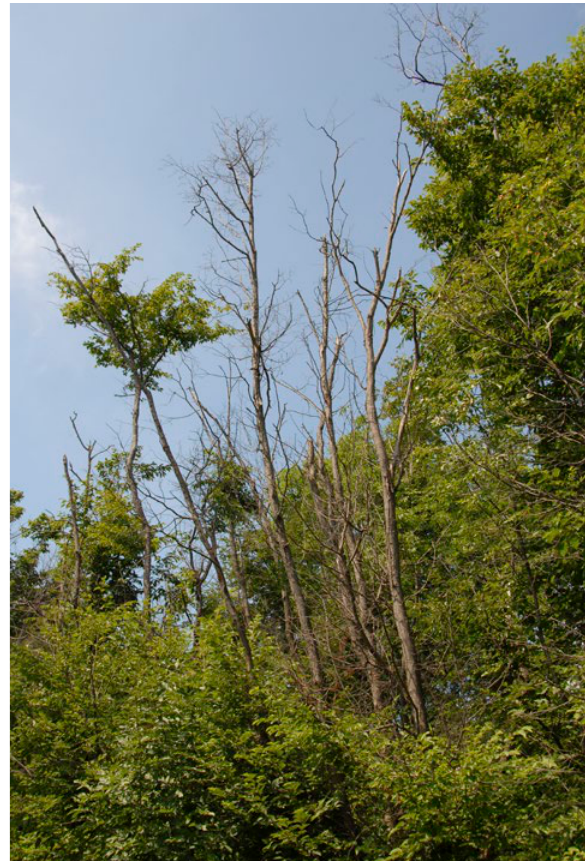
Figure 1. Extensive dieback symptoms on twigs and branches of Ostrya carpinifolia